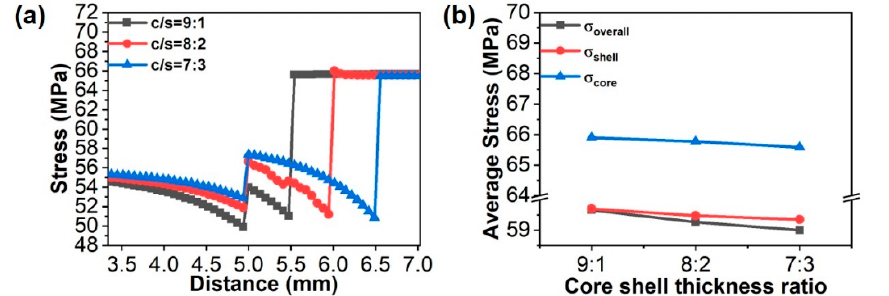
Figure 5. ( a ) Path I stress distribution curve with different core–shell thickness ratios; and ( b ) Average stress of the core, shell, and the entire model with different core–shell thickness ratios.